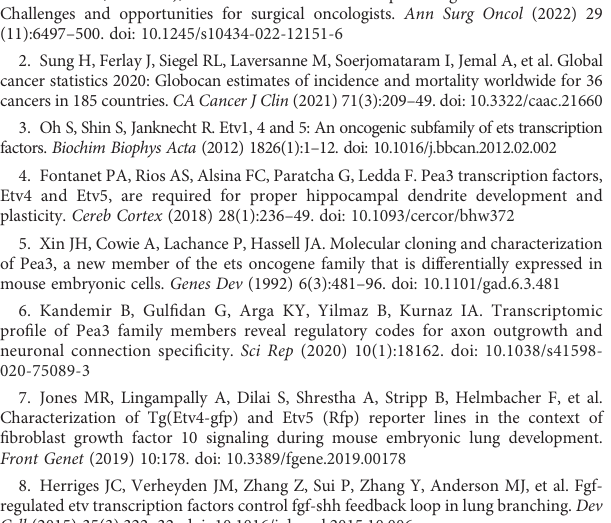
SUPPLEMENTARY TABLE 1 The abbreviations of